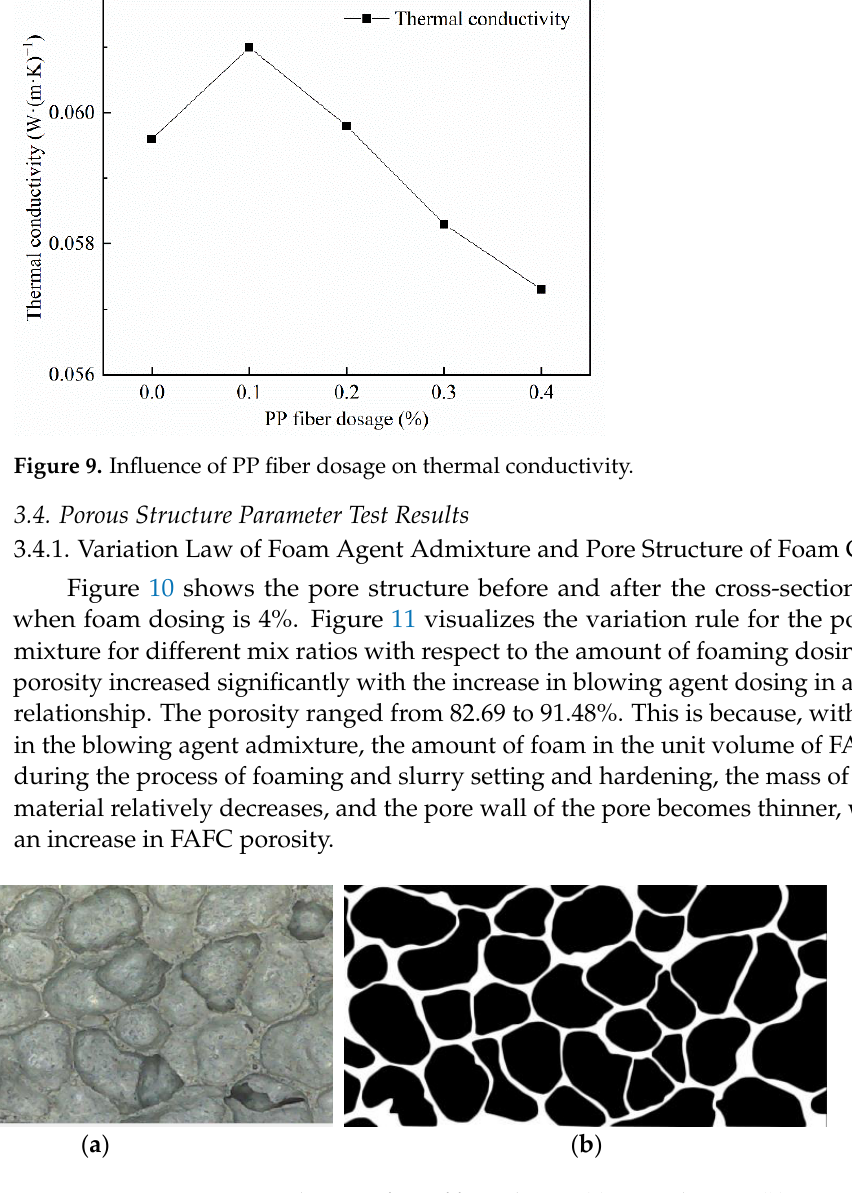
Figure 9. Influence of PP fiber dosage on thermal conductivity .